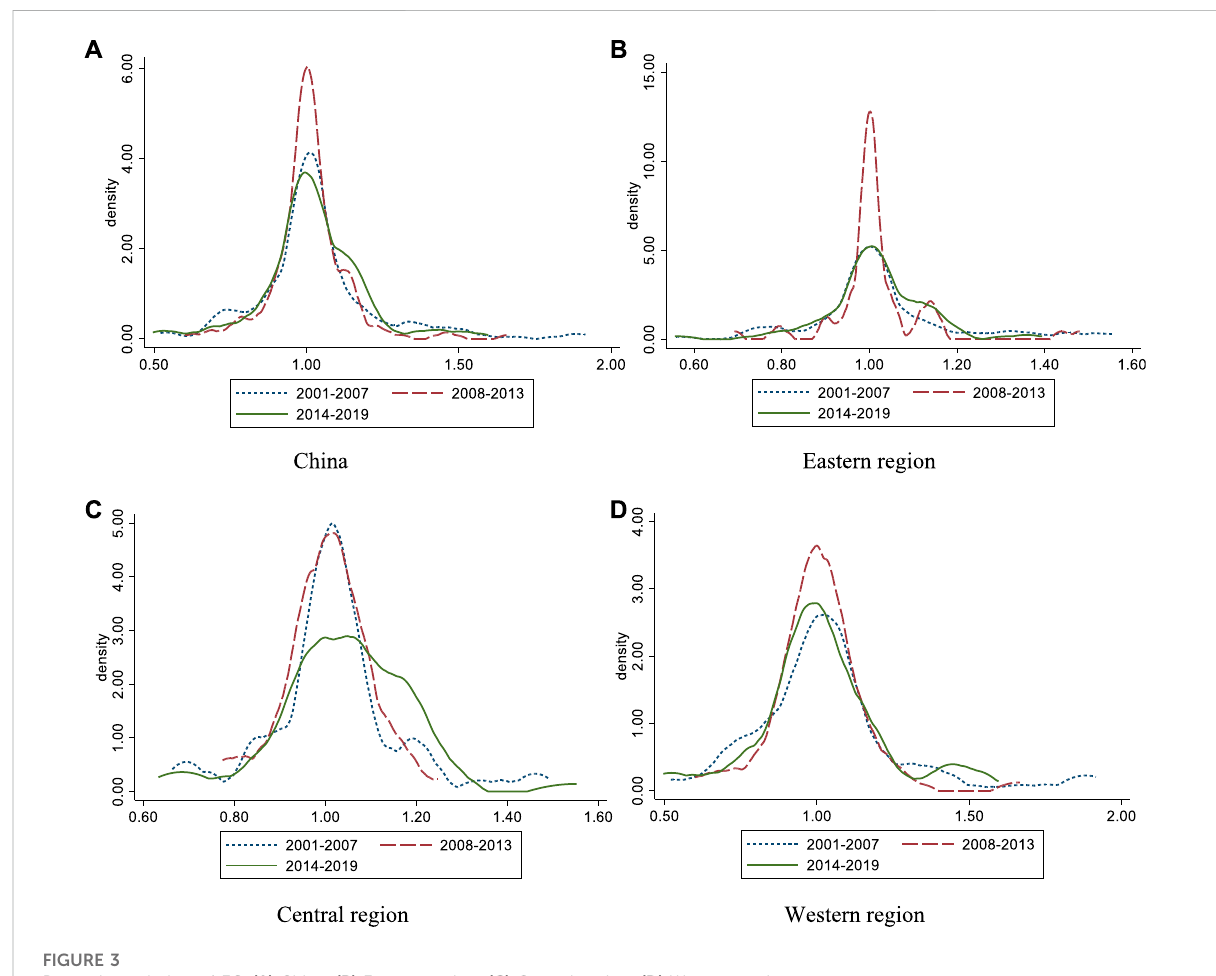
FIGURE 3 Dynamic evolution of EC . (A) China, (B) Eastern region, (C) Central region, (D) Western